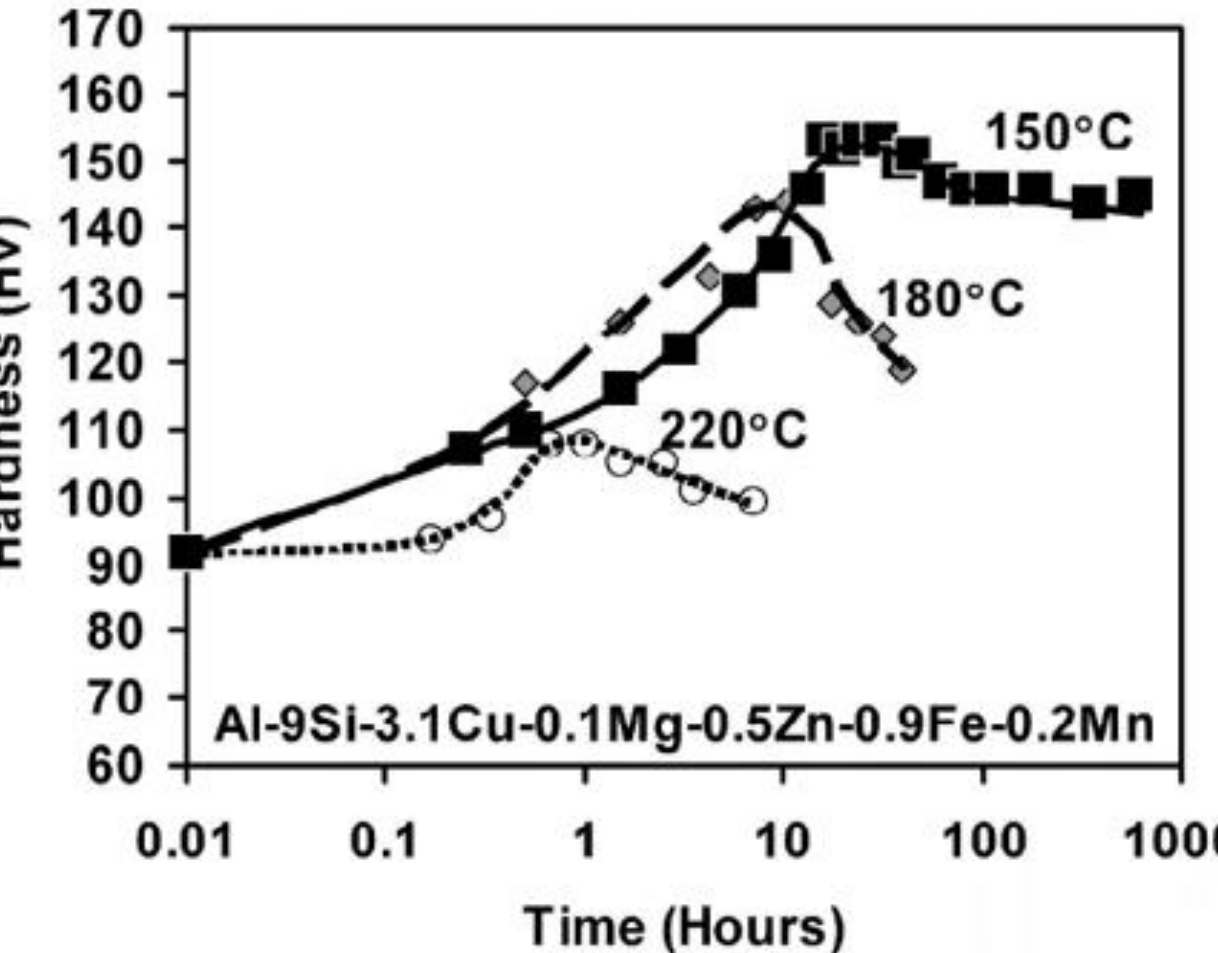
Figure 8. Age-hardening responses of Al-9%Si-3%Cu alloy based on varying aging temperatures [213]. Reproduced with permission from Trans Tech Publications, Ltd., Switzerland.